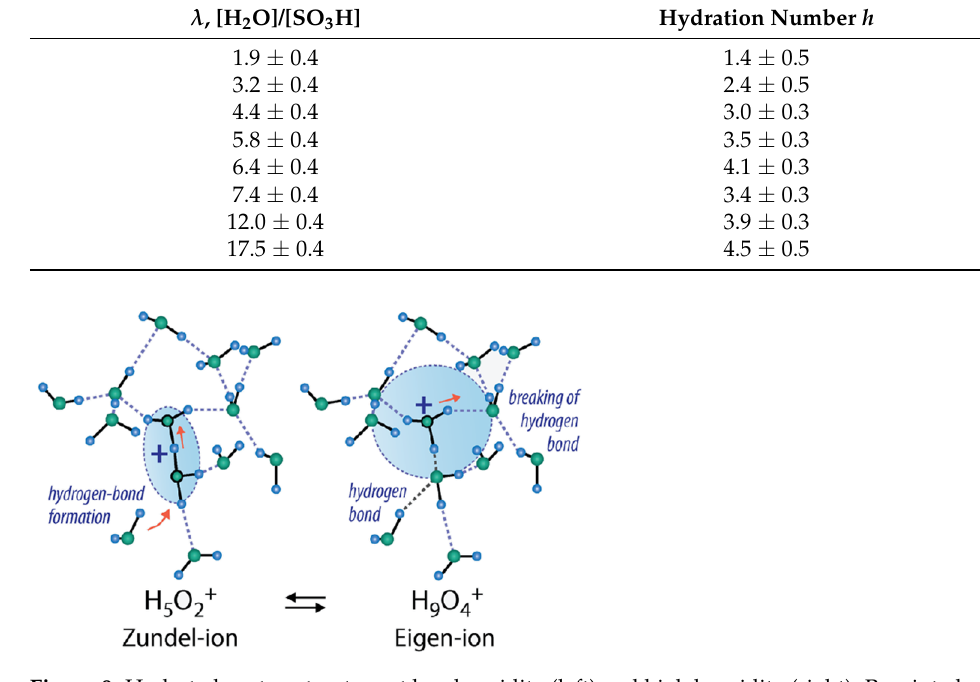
Figure 9. Hydrated proton structure at low humidity (left) and high humidity (right). Reprinted with permission from Ref. [58]. Copyright © 2022 American Chemical Society. Table 2. Hydration number h at different absolute amounts of water molecules per ionic site SO 3− ( λ ) in the acidic form of the Nafion 117 membrane. Reprinted with permission from Ref. [41]. Cop- yright © 2022 Springer-Verlag GmbH Austria, part of Springer Nature. λ , [H 2 O]/[SO 3 H]